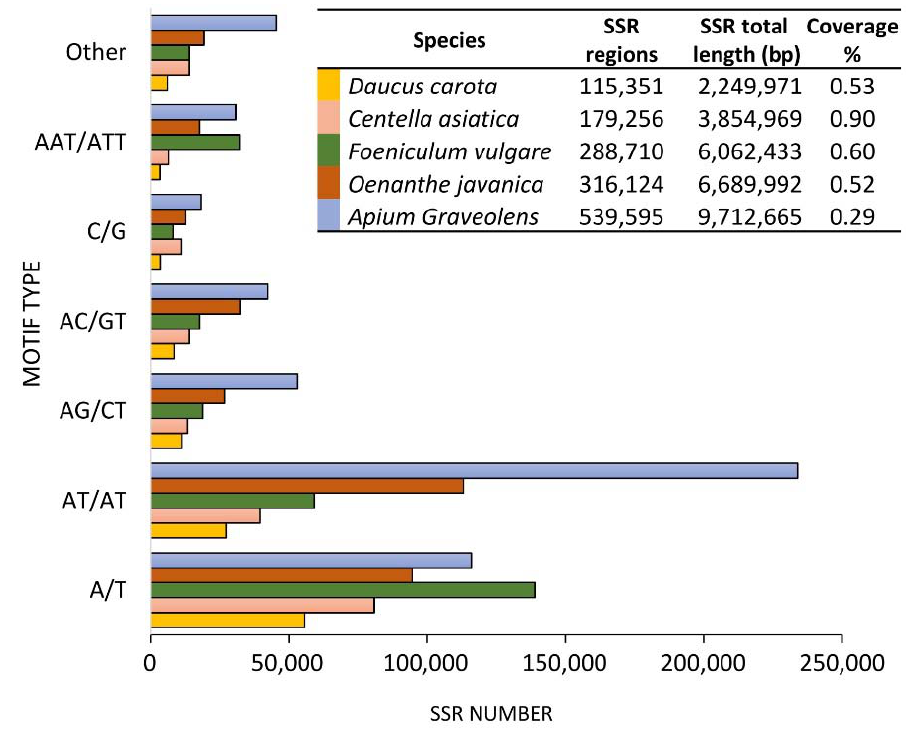
Figure 3. Distribution of the six most abundant microsatellite motifs in the five Apiaceae species for which genomes are publicly available. The table indicates the number of SSR regions identified in each genome, the total length (in bp) of the SSR regions, and the % of microsatellites on the overall genome size.